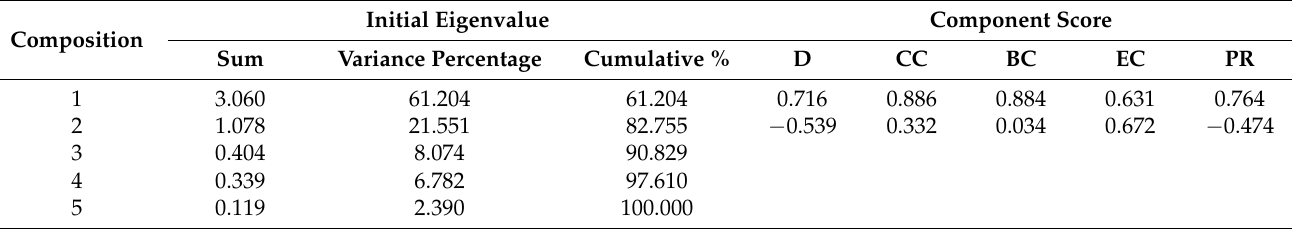
Table 4. Scores calculated by